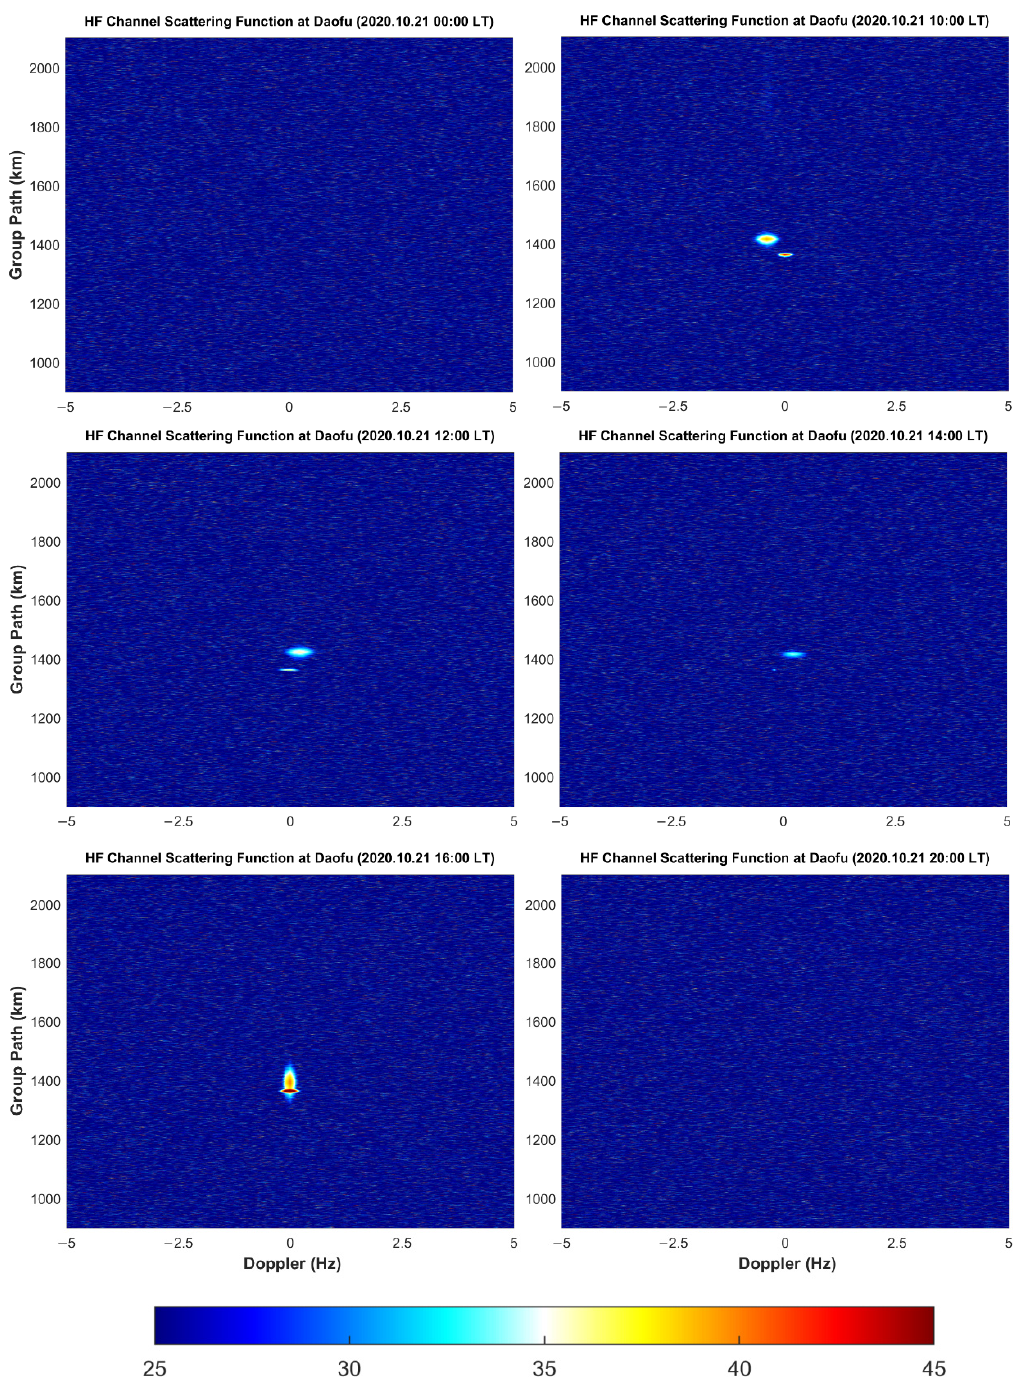
Figure 13. 21 October 2020. The modeling and simulation results of the HF channel at Daofu station.